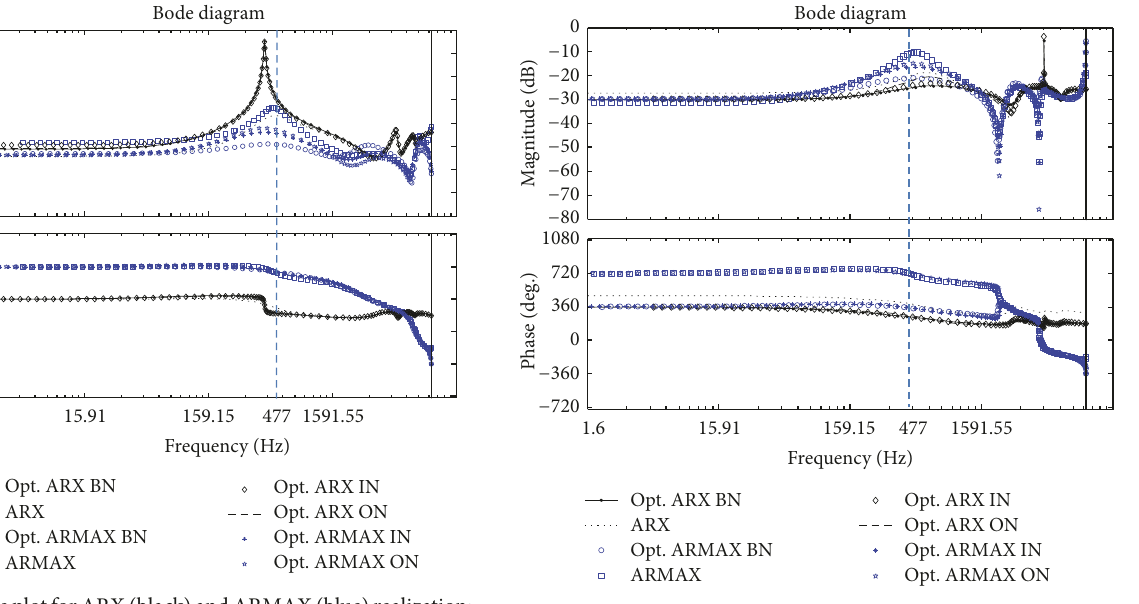
Figure6:BodeplotforARX(black)andARMAX(blue)realization; flow coefficient =